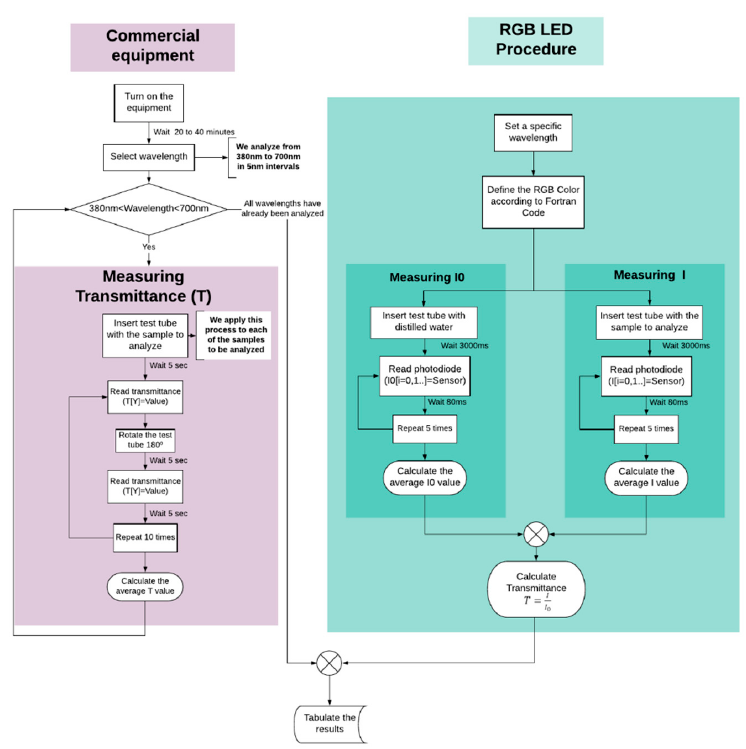
Figure 4. Scheme of the work methodology.